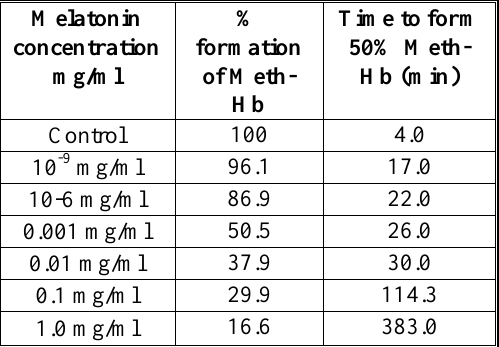
Figure 2. Effect of melatonin on the time course of methhemoglobin formation at various time intervals from nitrite addition. Table( 1) : Time to form 50% Meth-Hb in presence of different concentrations of